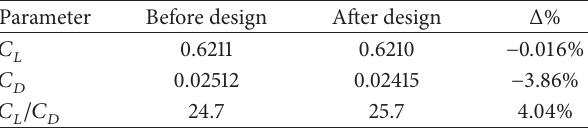
Table 5: Optimization results of rigid